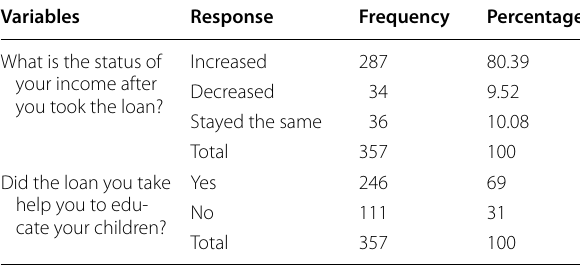
Table 4 Income change and children education enrollment of the respondents after taking the loan. Source : Author’s Survey Variables